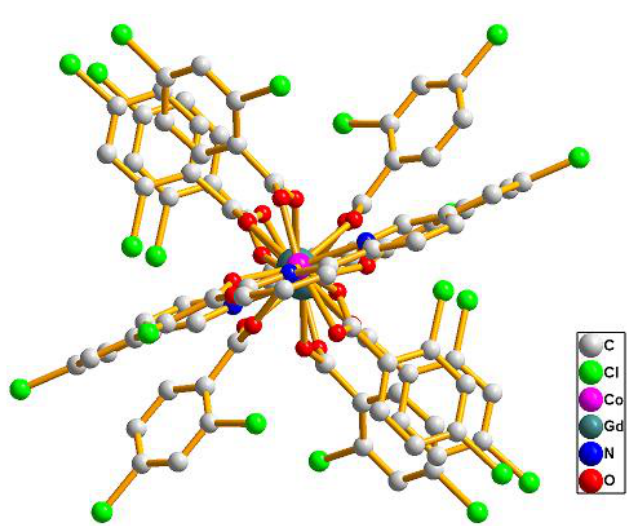
Figure 4. The distorted Capped Trigonal Prismatic coordination geometry of the Gd(III) ion in 8 with the GdO 7 sphere.